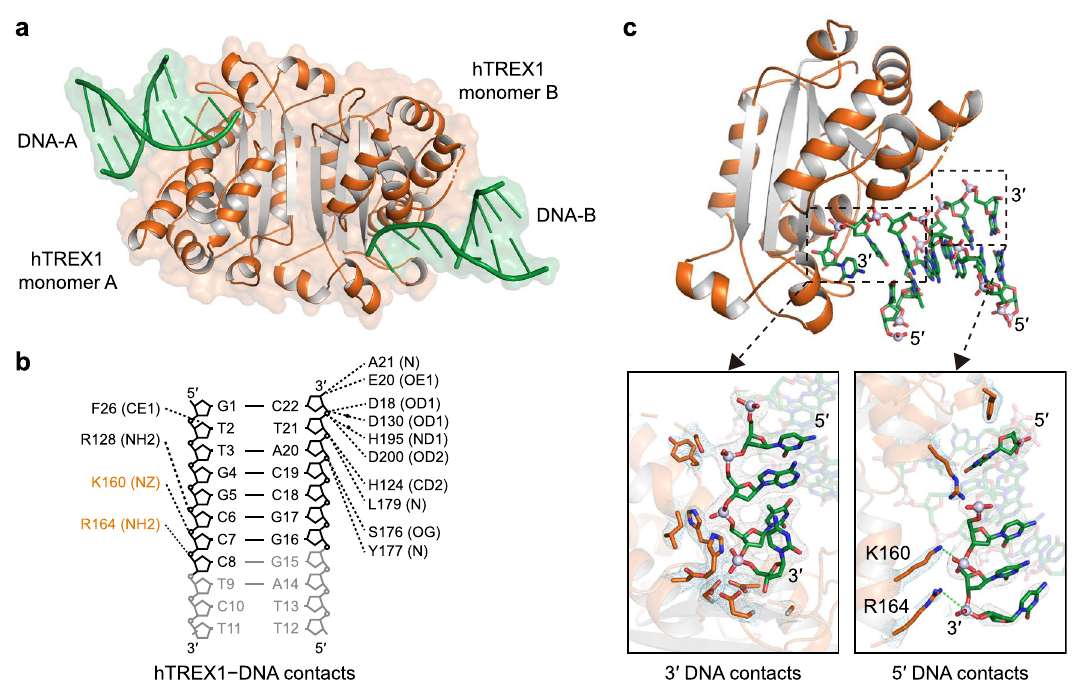
Fig. 2 | Structural analysis of human TREX1. a Overview of the human TREX1 dimer. Human TREX1 Chi 5.1 (A5T/P8H/P10H) organizes as two molecular dimer. The corresponding dimer interface and enzymatic pocket are highlighted. b Zoom-in cutaway showing location of site potentially needed for crystal for- mation. Similar to the observation in mTREX1 structural model, the P10H sub- stitution hTREX1 makes direct contacts with C-terminal D220. This interaction Fig. 3 | Mechanism of hTREX1-DNA recognition. a Overview of the human TREX1 – DNA complex. Human TREX1 forms a 2:2 complex with DNA where each TREX1 monomer has one DNA binding surface. b Schematic map of protein – DNA contacts in the hTREX1 – DNA complex. Human-speci fi c contacts are highlighted in orange, and black dots denote interactions bridged by water molecules. See also